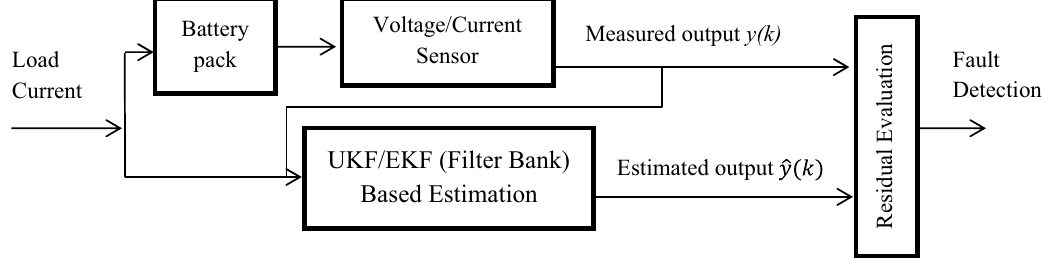
Figure 1. Schematic diagram of UKF/EKF bank-based fault detection